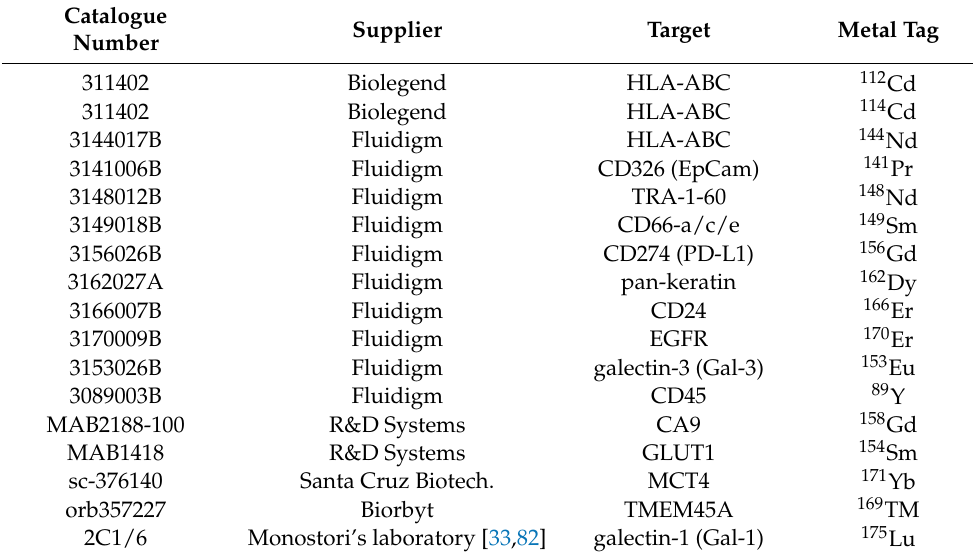
Table 1. Antibodies used for mass